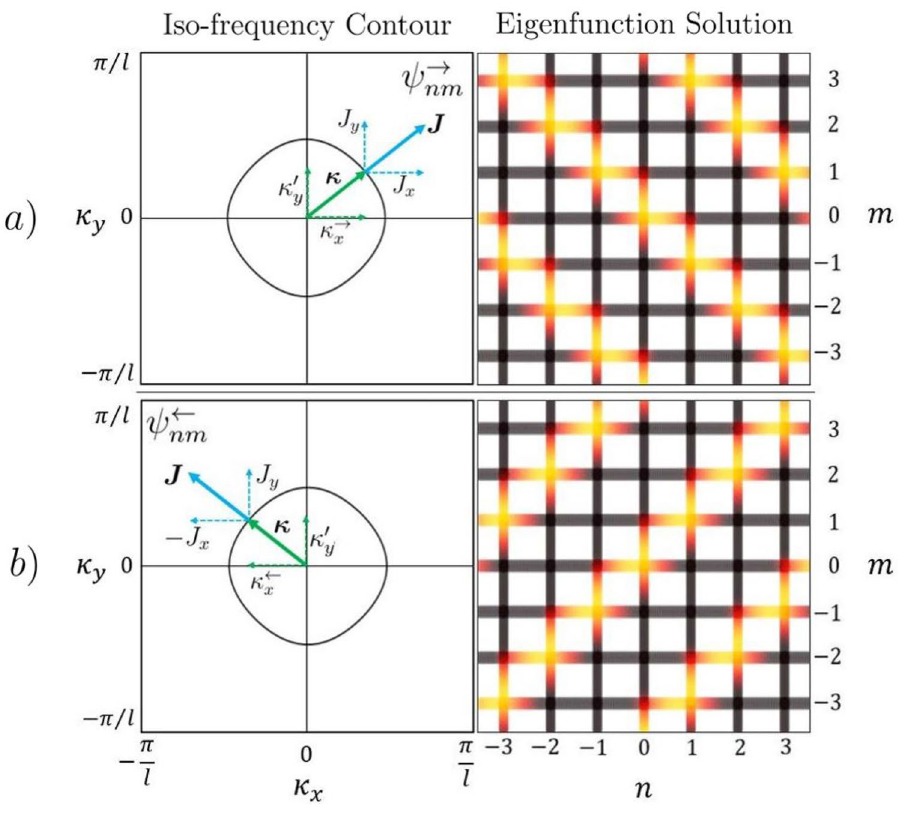
T in ( a ) and κ T , κ , κ (κ → (κ ← ′ y ) ′ y ) x x = = ( J x , J y ) T and J ( J x , J y ) T normal to = = −